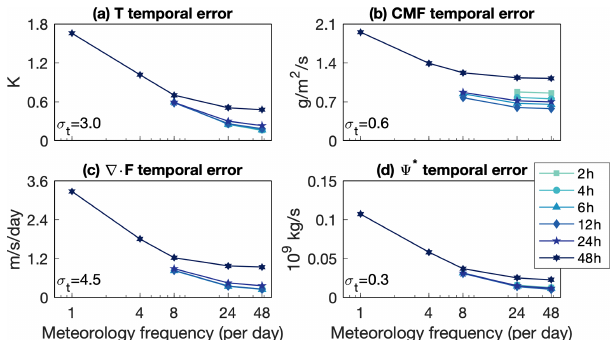
Figure 2. Globally and vertically averaged root-mean-square tem- poral error in (a) temperature, (b) convective mass flux, (c) EP flux divergence, and (d) the TEM streamfunction as a function of me- teorology frequency (horizontal axis) and nudging timescale (see legend). For reference, the globally and vertically averaged tempo- ral standard deviation of each field is shown in each panel.